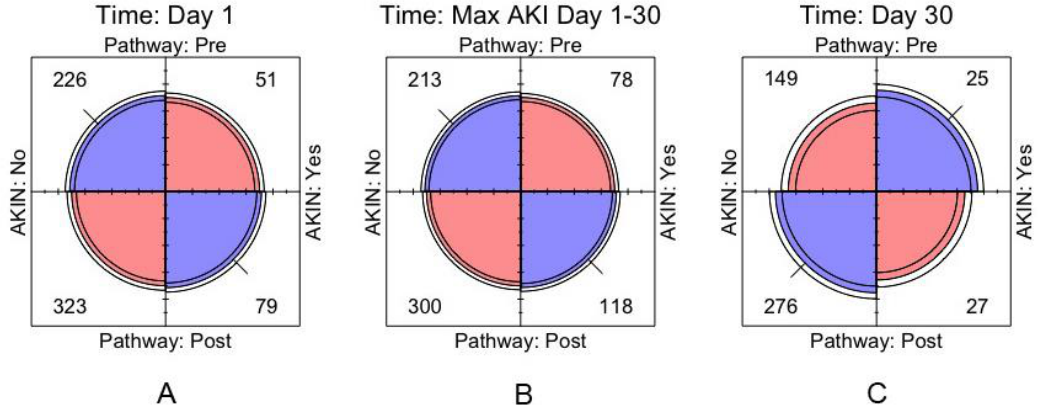
Figure 4. Cumulative AKI incidence ( A ) Day 1, ( B ) Max (day1-day30) and ( C ) Day 30 post-op pre and post-ELPQuiC implementation: